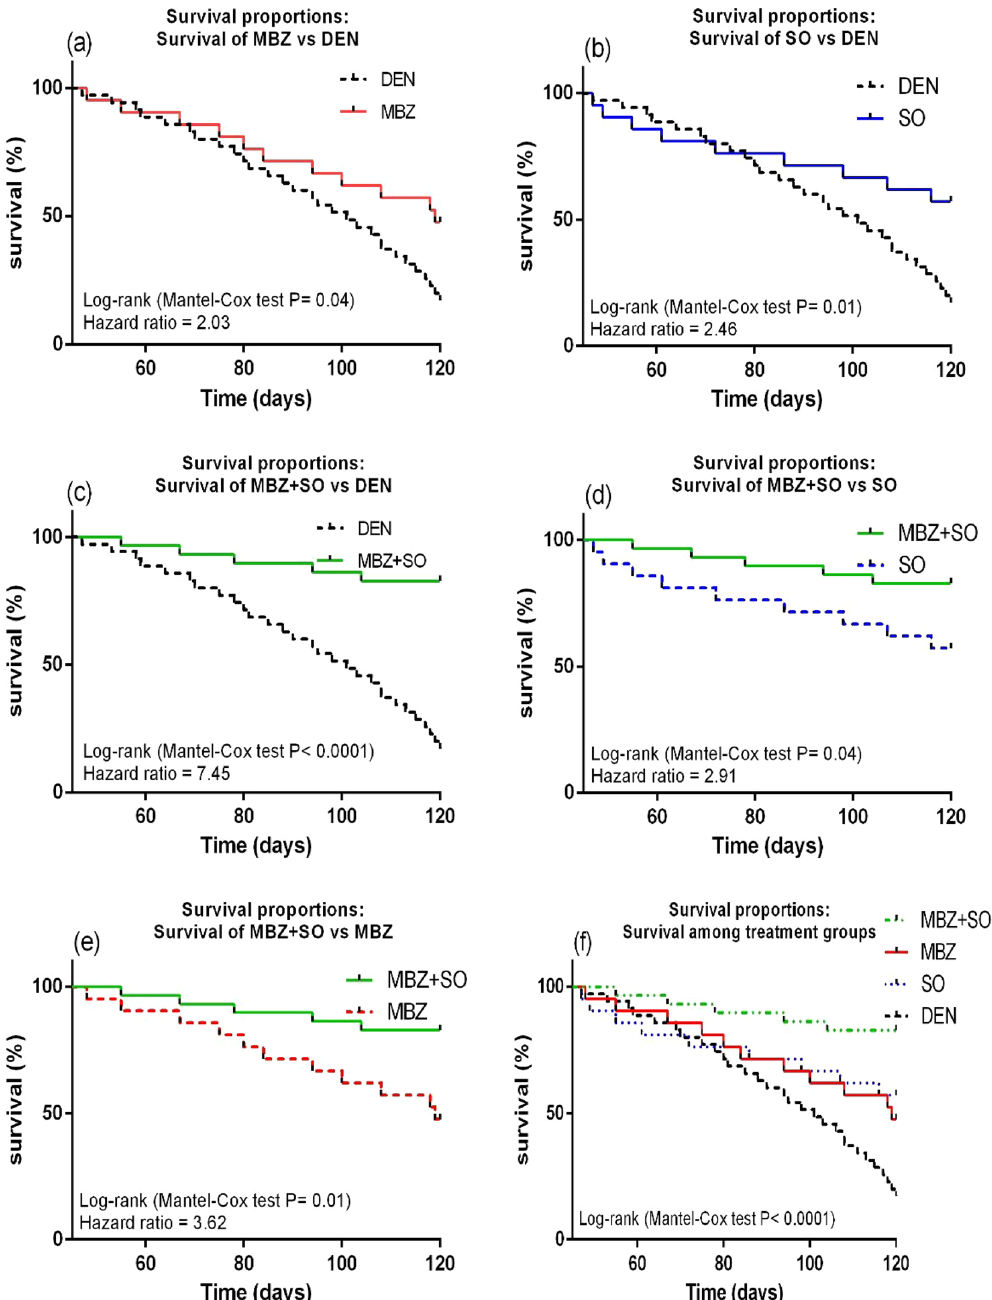
Figure 10. Kaplan–Meier survival plots of ( a ), MBZ vs. DEN; ( b ), SO vs. DEN; ( c ), MBZ + SO vs. DEN; ( d ), MBZ + SO vs. SO; ( e ), MBZ + SO vs. MBZ and ( f ), survival proportions between treatment groups. Statistical analysis was done using the log rank test (Mantel-cox method). P values < 0.05 were considered